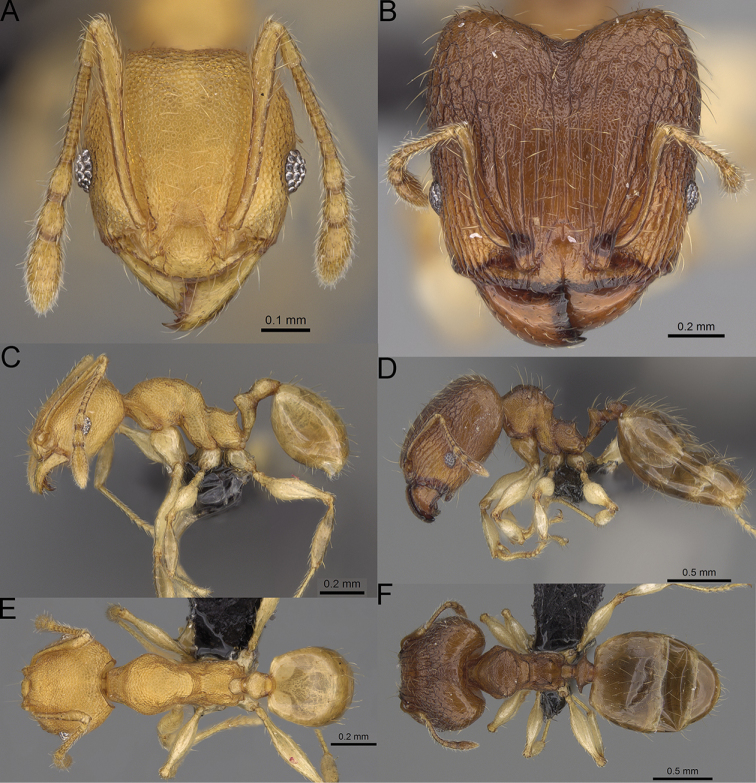
Pheidole
bemarivoensis sp. nov., full-face view (A), profile (C), and dorsal view (E) of paratype minor worker (CASENT0923160) and full-face view (B), profile (D), and dorsal view (F) of holotype major worker (CASENT0489439).